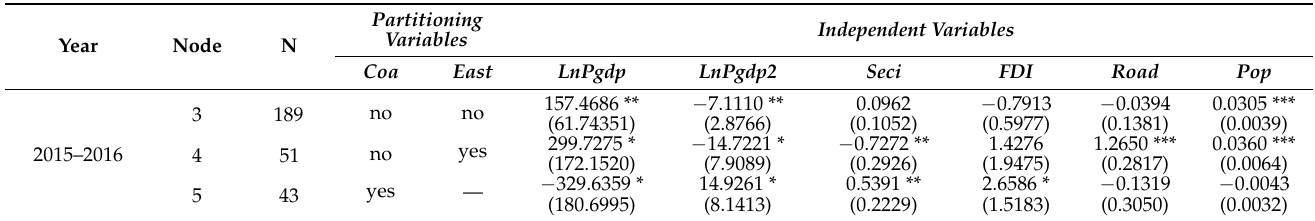
Table A4. Results of a recursive analysis of air pollution influences for the period